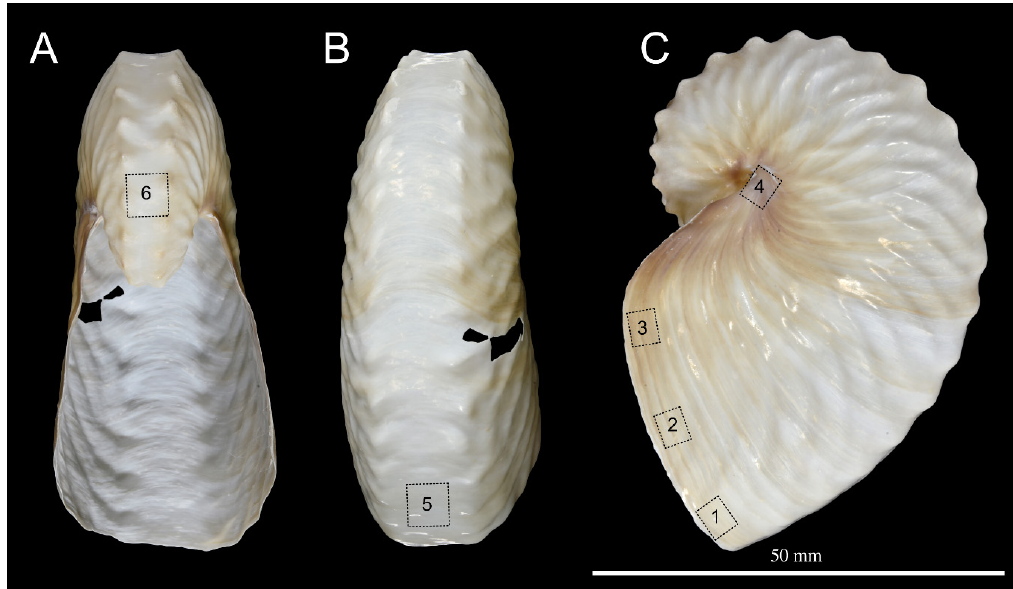
Figure 1. Macrophotography of the shell of Argonauta hians . ( A ). Apertural view. ( B ). Dorsal view. ( C ). Left lateral view. Note the pigmented protuberances of the keel. The dashed squares with numbers indicate the location of area sampled for SEM investigation of the shell wall.